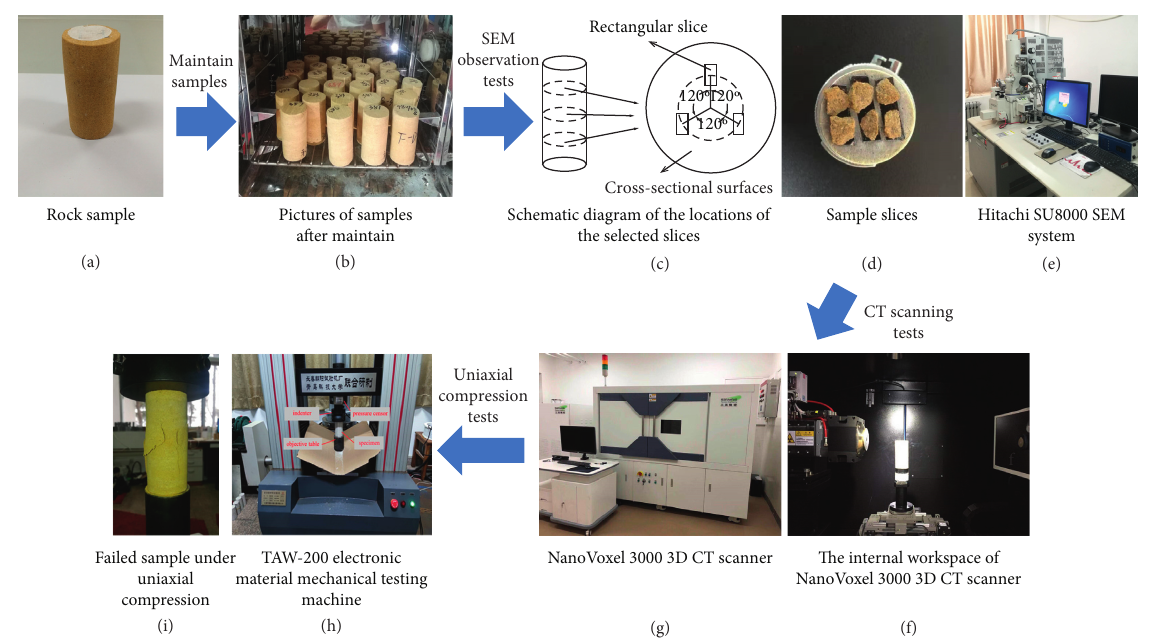
Figure 1: Experimental procedures and equipment. (a) Rock sample. (b) Pictures of samples after the maintenance period. (c) Schematic diagram of locations of the selected slices. (d) Sample slices. (e). Hitachi SU8000 SEM system. (f) Internal workspace of the nanoVoxel 3000 CT scanner. (g) nanoVoxel 3000 CT scanner. (h) Photograph of the TAW-200 electronic material mechanical testing machine. (i) Photograph of a sample that failed under uniaxial